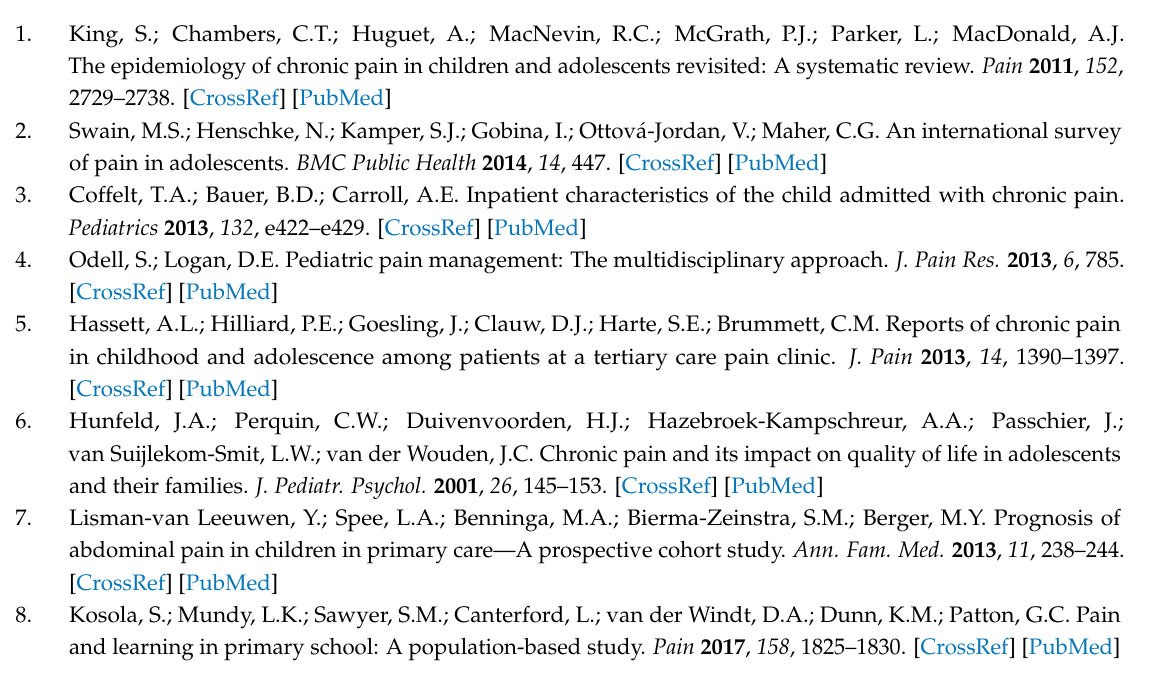
Online Survey; Table S2: Categorization of domains suggested by experts; Table S3: Data used to create Figure 1; Table S4: Data used to create Figures 2 and 3; Table S5: Data used to create Figure